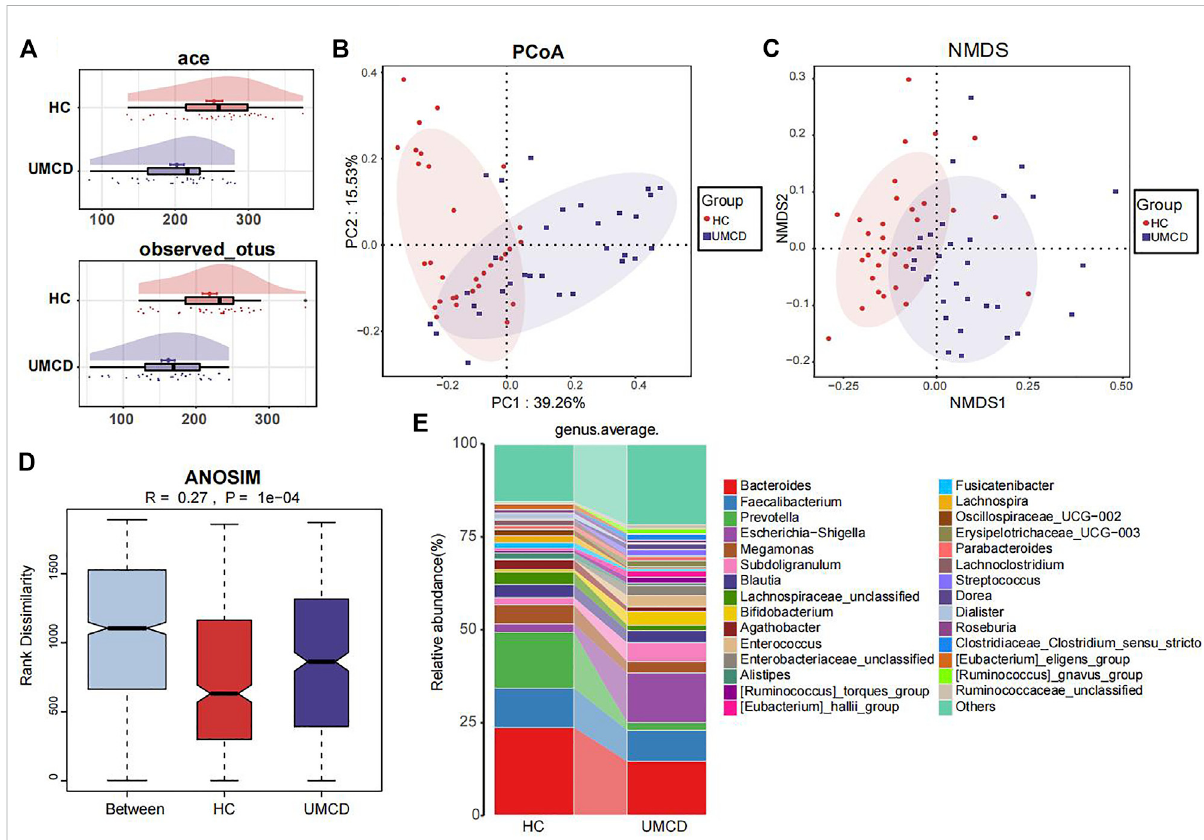
FIGURE 2 Comparison of gut microbiota composition in discovery cohort (UMCD = 30, HC = 31). (A) The ace index ( p < 0.001) and observed OTUs ( p < 0.001) showed α -diversity decreased in UMCD. (B) PCoA diagram showed the weighted UniFrac distance had obviously difference between UMCD and HCs. (C) NMDS showed differentdistancesin compositionof gut microbiota. (D) ANOSIM diagram showed signi fi cant differences betweenHCs and UMCDs. (E) Average relative abundance at genus level in HCs and UMCDs were compared. PCoA, principal coordinate analysis; NMDs, Non-metric multidimensional scaling; ANOSIM, analysis of